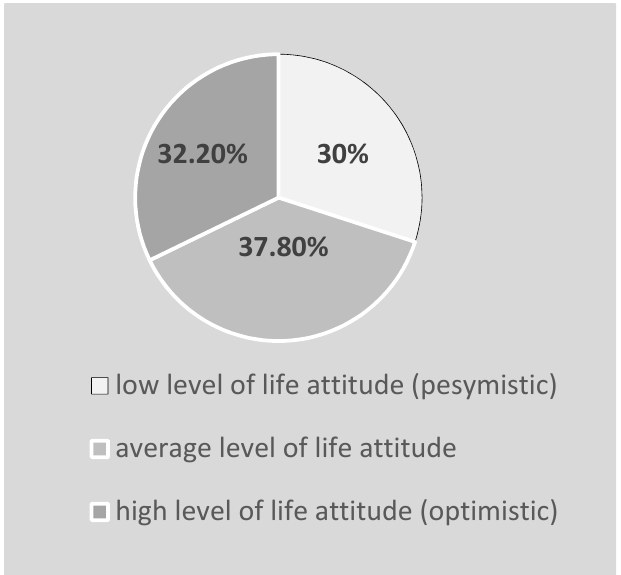
Figure 4. The life attitude of the surveyed students of nursing.